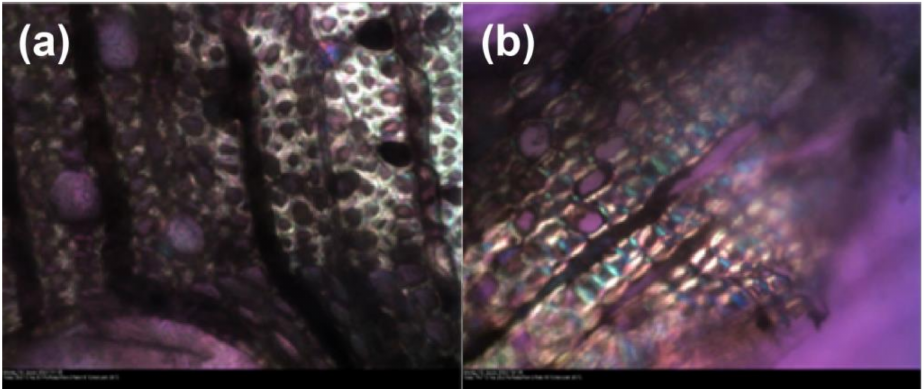
Figure A1. Optical microscope images of the wood with ( a ) 1 wt.% chitosan solution and ( b ) water, magnification 65 × .